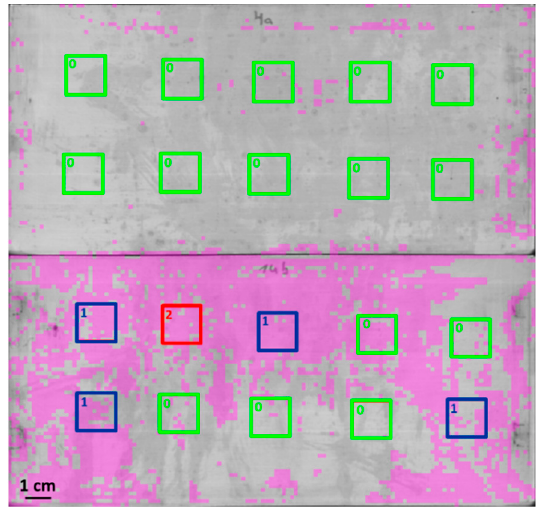
Figure 7. Example of the prediction of coating adhesion for two battery cells with the NIR-b-bc data set and the best prediction model found. Purple boxes show areas where the 2-class model predicts reduced coating adhesion (cross-cut value unequal 0). Colored boxes show the coating adhesion classes estimated by the cross-cut test (cross-cut value 0, 1, or 2).